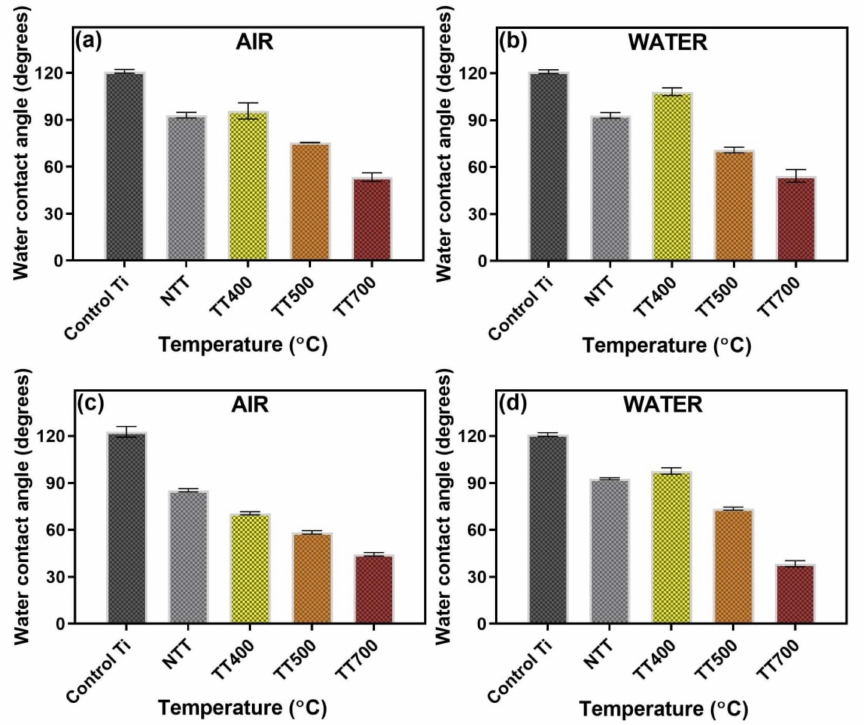
Figure 11. The values of the contact angle obtained in the case of control (Ti), NTT LiC ( a , b ) and LiP ( c , d ) coatings, and of those subjected to post-deposition thermal treatments (at different temperatures), in air ( a , c ) and water-vapor ( b , d ) ambient. Test liquid: water.